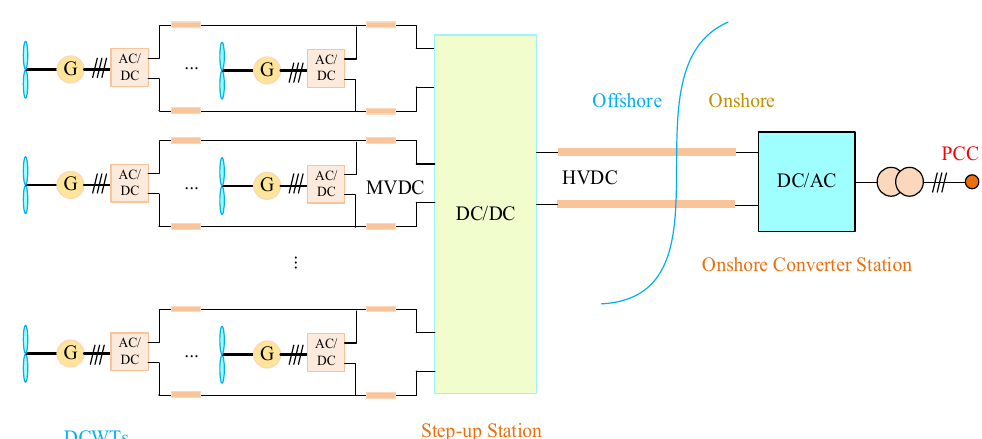
Fig. 14 All-DC OWF parallel-connection WTs